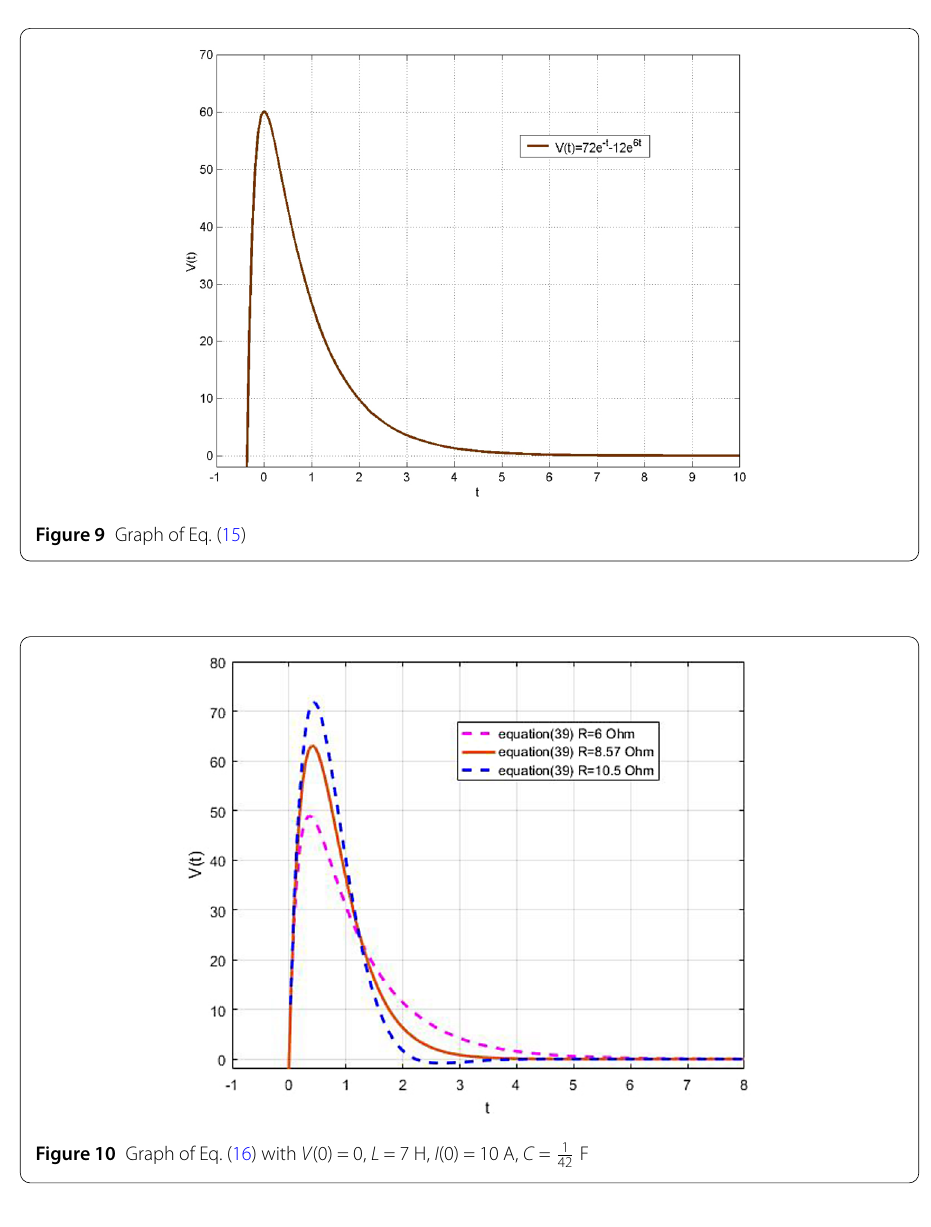
Figure 10 Graph of Eq. (16) with V (0) = 0, L = 7 H, I (0) = 10 A, C = 1